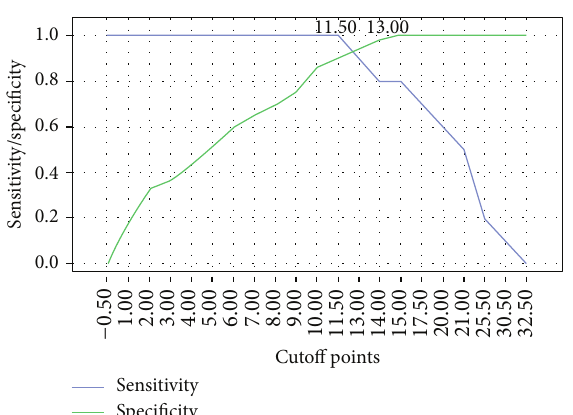
Figure 1: The receiver operating characteristics curve. The SDQ-P cutoff score is equal to 12.59 points, the specificity is 91.2%, and the sensitivity is 96.7% ( 𝑥 -axis: the cutoff points for the SDQ-P and 𝑦 -axis: the sensitivity and the specificity).